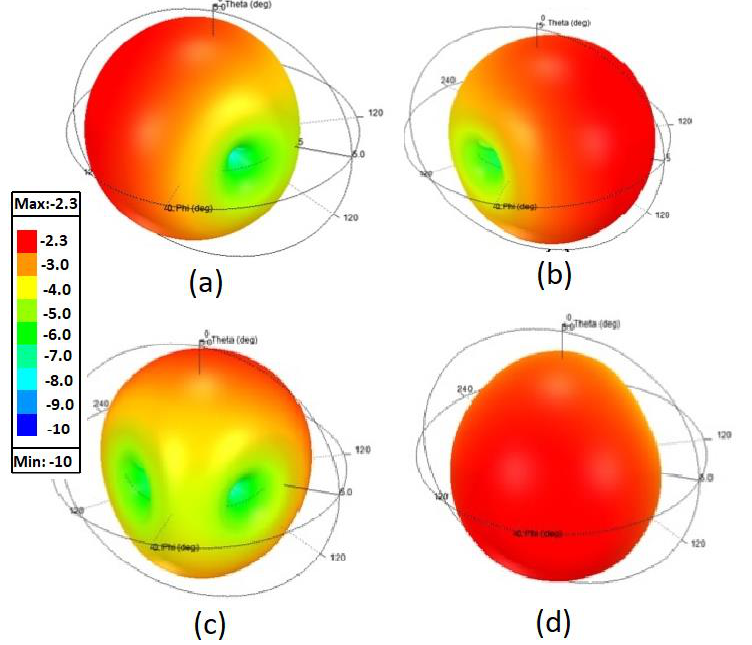
Figure 7. 3D radiation patterns of the proposed CubeSat MIMO antenna at 450 MHz: ( a ) Ant-1, ( b ) Ant-2, ( c ) Ant-3, ( d ) Ant-4.